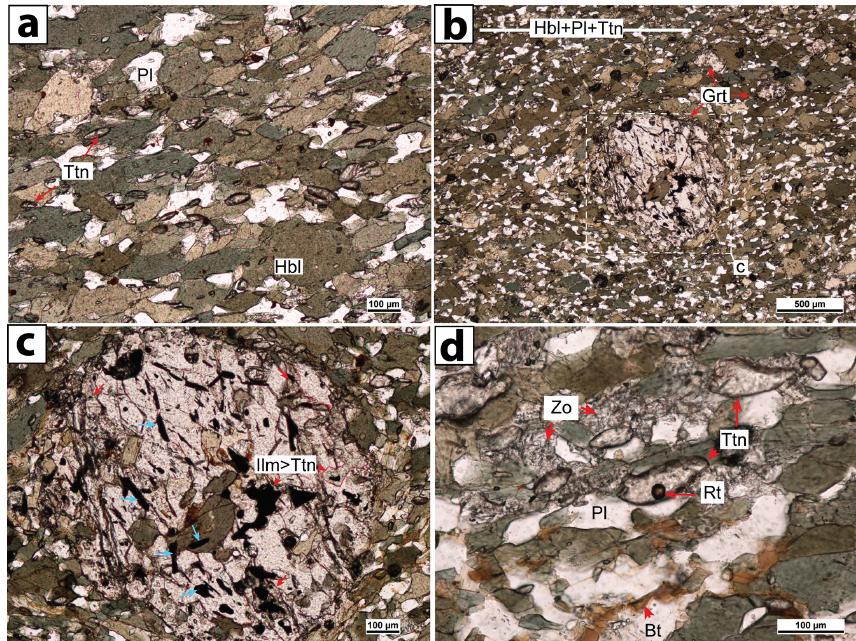
Figure 3. Fine-grained amphibolites (sample JBP-71-21) from the basal mylonitic band in the Sobrado upper tectonic slice. (a) Hornblende– plagioclase mixtures and titanite with preferred orientation, defining the mylonitic fabric. (b) Main fabric surrounding a garnet porphyroclast. Note that titanite is the Ti phase in the mylonitic fabric but ilmenite grains have been preserved inside the garnet. The position of panel (c) is indicated by a dashed white square. (c) Garnet inclusions from panel (b) where ilmenite inclusions show a progressive breakdown into titanite (Ilm < Ttn). Note ilmenite inclusions inside pristine garnet areas show no evidence of transformation. (d) Inclusions of rutile inside titanite and partial transformation of plagioclase into zoisite. All micrographs are in plane-polarized light (PPL). (Mineral abbreviations are after Whitney and Evans, 2010; Hbl: hornblende, Ttn: titanite, Ilm: ilmenite, Rt: rutile, Pl: plagioclase, Zo: zoisite, Grt: